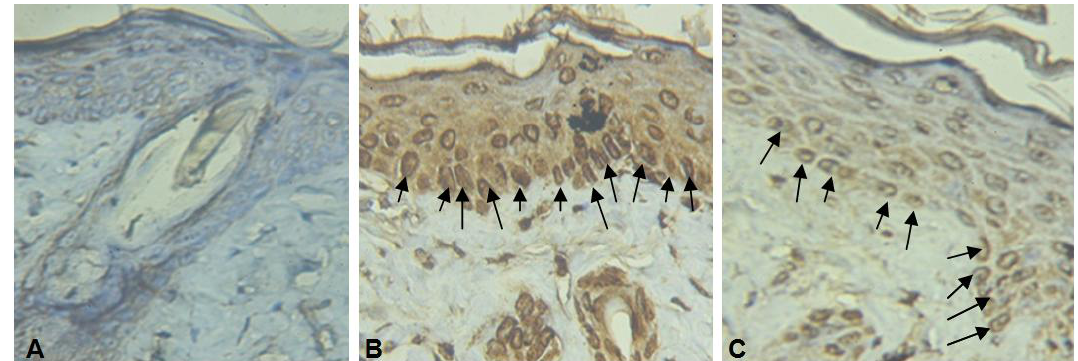
Figure 1. The observation of expression of CPDs using immunohistochemical method (original magnification